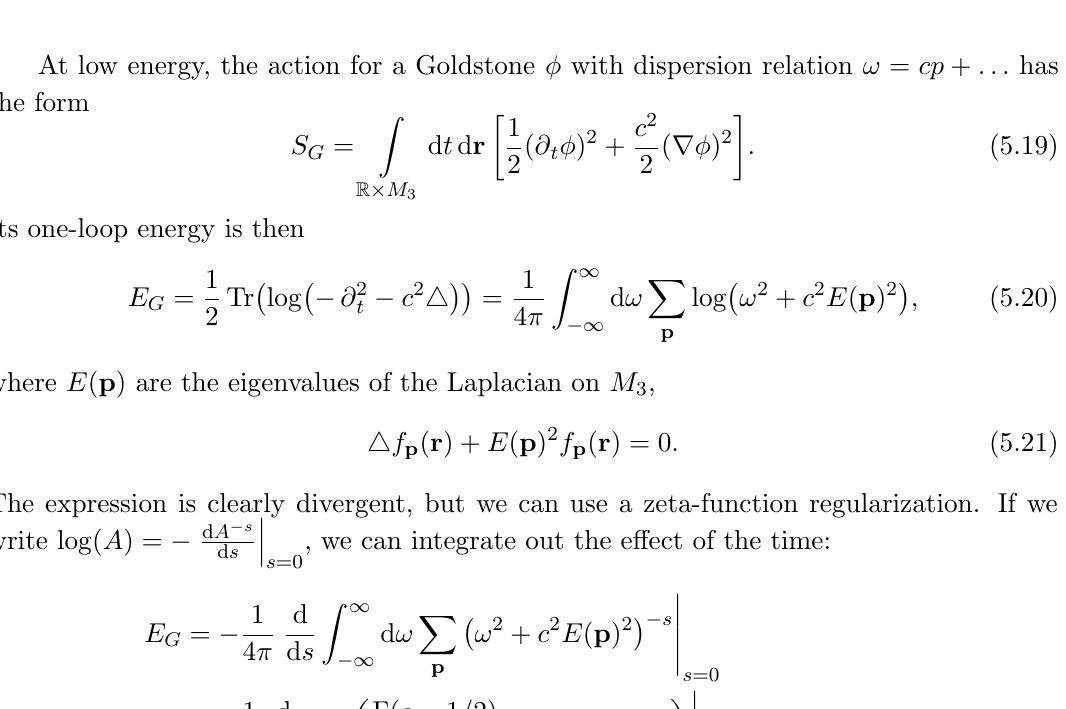
The Goldstone spectrum resulting from (cid:12)xing the charges in the sector f J; : : : ; J , (cid:0) J; : : : ; (cid:0) J g . The N 2 (cid:0) 1 DOF stemming from the breaking of the global symmetry are arranged F into a singlet (the conformal Goldstone), two adjoints of SU( N F = 2) and a pair of bifundamentals (that together form a single bifundamental type-II Goldstone). The type-I Goldstones contribute to the zero-point energy according to their velocities. The type-II Goldstone has a quadratic dis- persion relation and has zero velocity. Not represented here is the spurious singlet corresponding to the anomalous axial